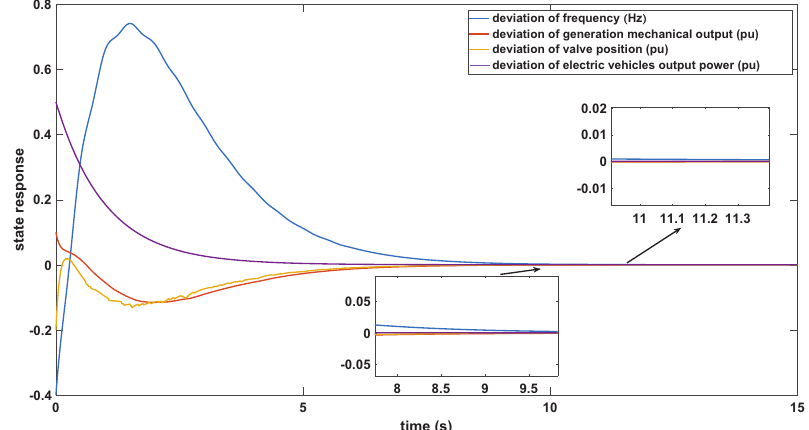
Figure 6. State trajectory of one-area power system.